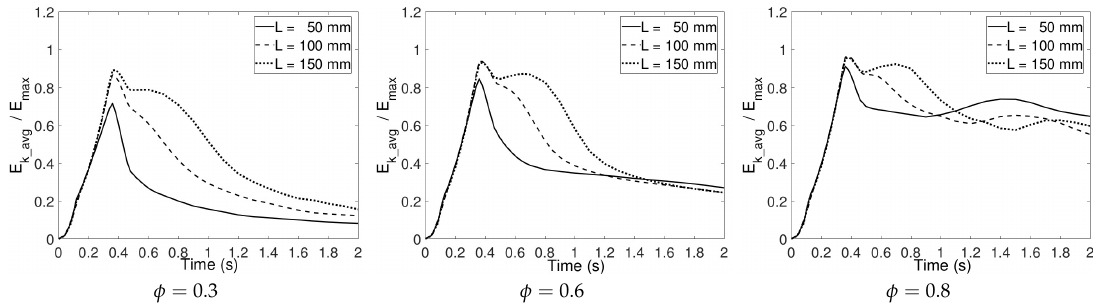
Figure 20. The effect of piston–screen distance on the kinetic energy of vortex rings.